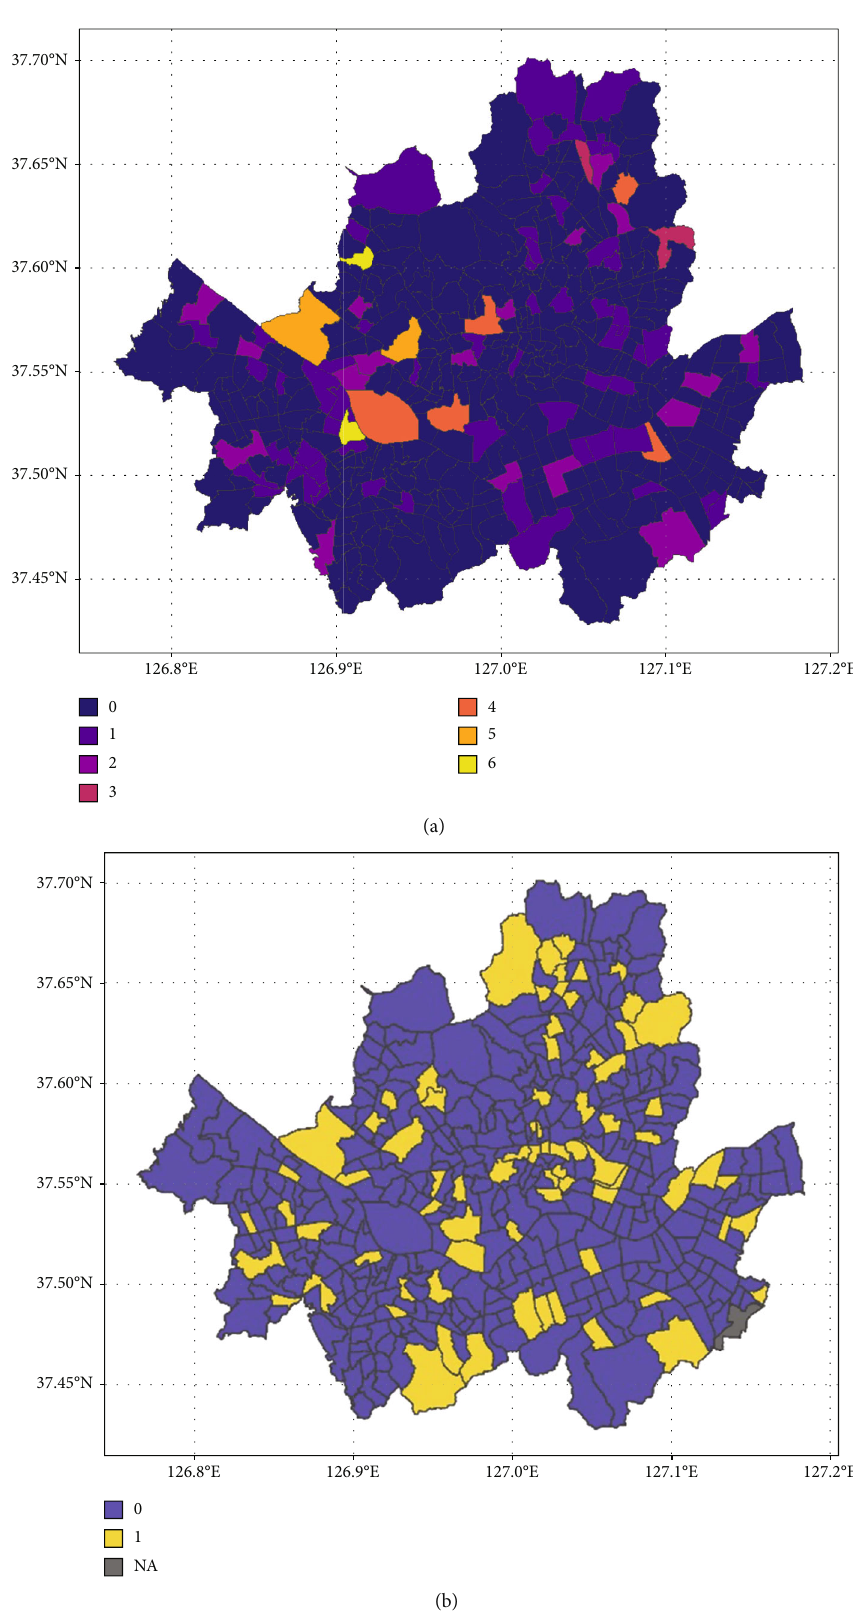
Figure 1: Distributions of demands at 5 p.m. on November 1, 2019. (a) Distribution of demands (continuous) at 5 p.m. (b) Distribution of demands (0/1) at 5